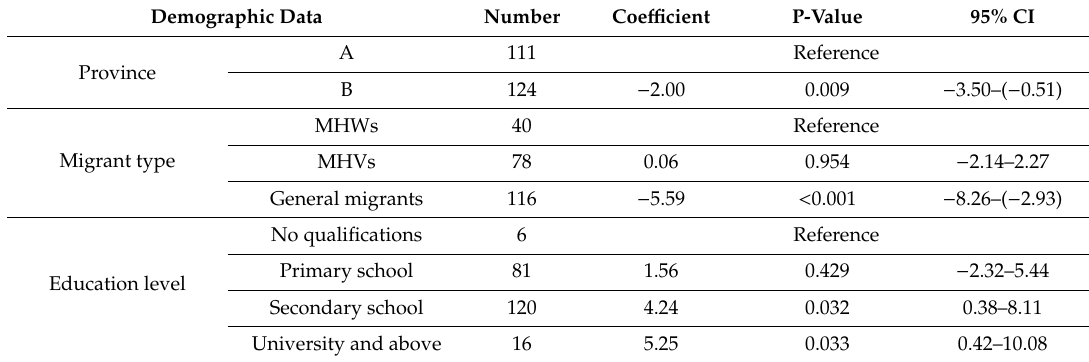
Table 2. Factors associated with health literacy score from multiple regression.